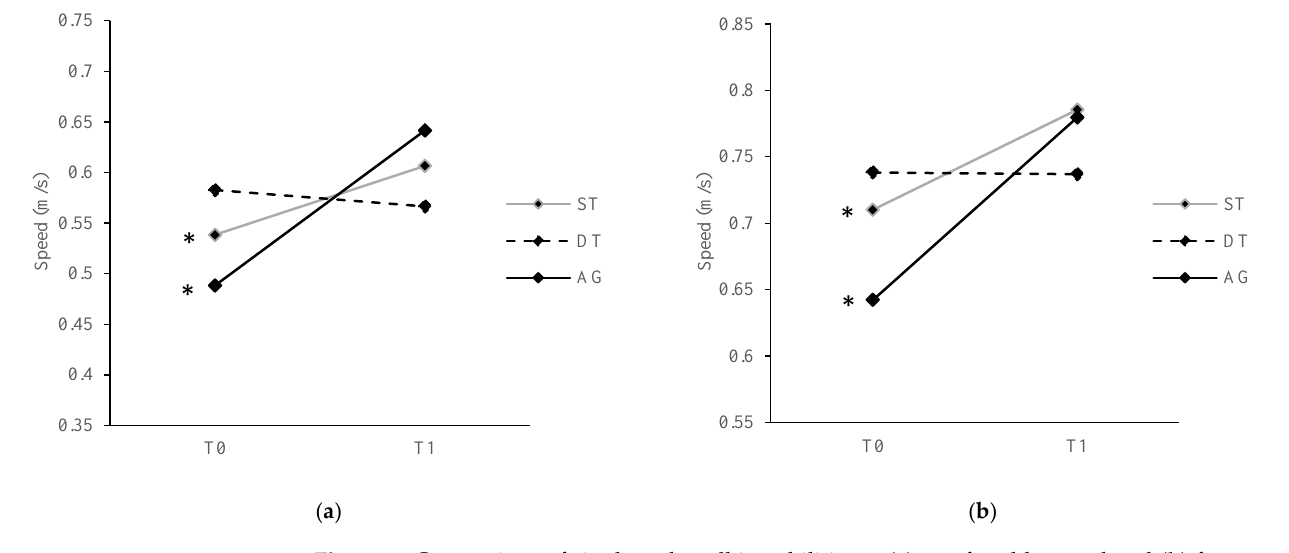
Figure 3. Comparison of single-task walking abilities at ( a ) comfortable speed and ( b ) fast speed from T0 to T1 for all training groups. * denotes p value < 0.05 for the difference between T0 and T1. ST, single-task training group; DT, dual-task training group; AG, analogy training group.